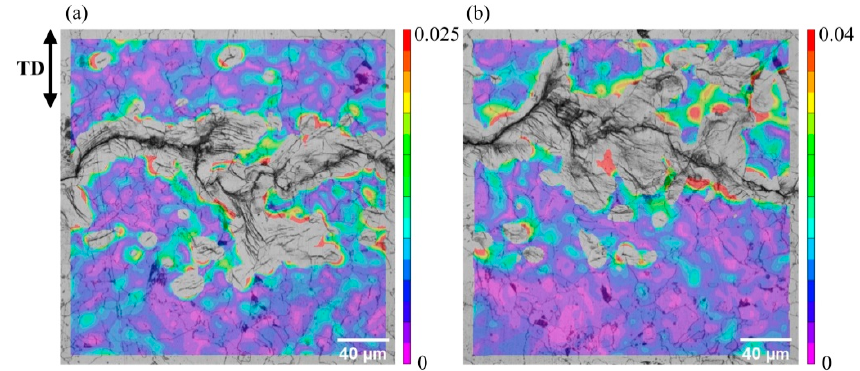
Figure 14. Von Mises strain fields of the TD1 specimen under a 50 × objective lens: ( a ) a = 1.25 mm, N = 55,000 cycles; ( b ) a = 1.75 mm, N = 75,000